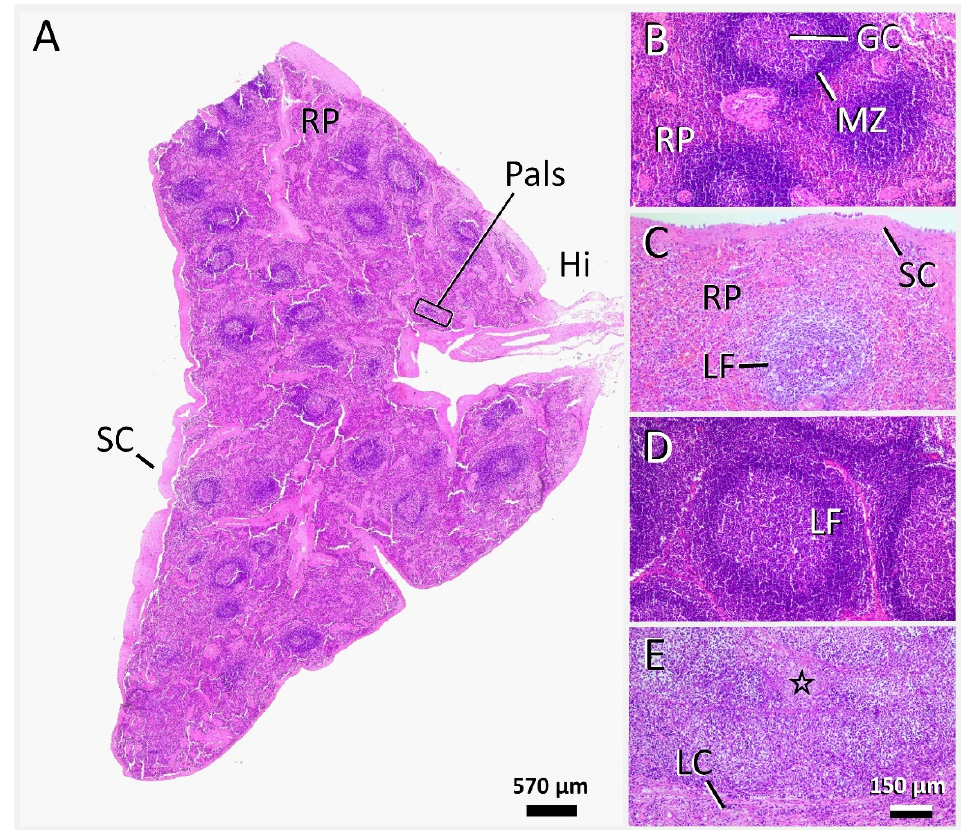
Figure 5. Lymphatic tissue changes in the cat ( A , B , D ) compared to a cat with active feline infectious peritonitis (FIP) ( C , E ). Follicular lymphoid hyperplasia was evident in all lymphatic tissues, including the spleen ( A , B ), lymph nodes ( D ), and Peyer’s patches and tonsils (not shown). Note the large lymphoid follicles ( A , B ; D : LF) with prominence of germinal centers ( A , D ; B : GC) and clearly delineated mantle zones ( A , D ; B : MZ). In the spleen ( A , B ), red pulp ( A , B : RP) and periarteriolar lymphoid sheaths ( A : Pals) were discernible, corresponding to splenic activation type 1 [15]. Lesions, typically associated with splenic ( C ) and lymph node ( E ) involvement in FIP, including effacement of follicular zones and delineation, as well as polymorphonuclear and macrophageal infiltrate and fibrin deposition ( E : asterisk), were not seen. Markers: GC, germinal center; Hi, hilus (spleen); LC, lymph node capsule; LF, lymph follicle; MZ, mantle zone; Pals: periarteriolar lymphoid sheath; RP, red pulp (spleen); SC, splenic capsule. Stain ( A – E ): hematoxylin–eosin.